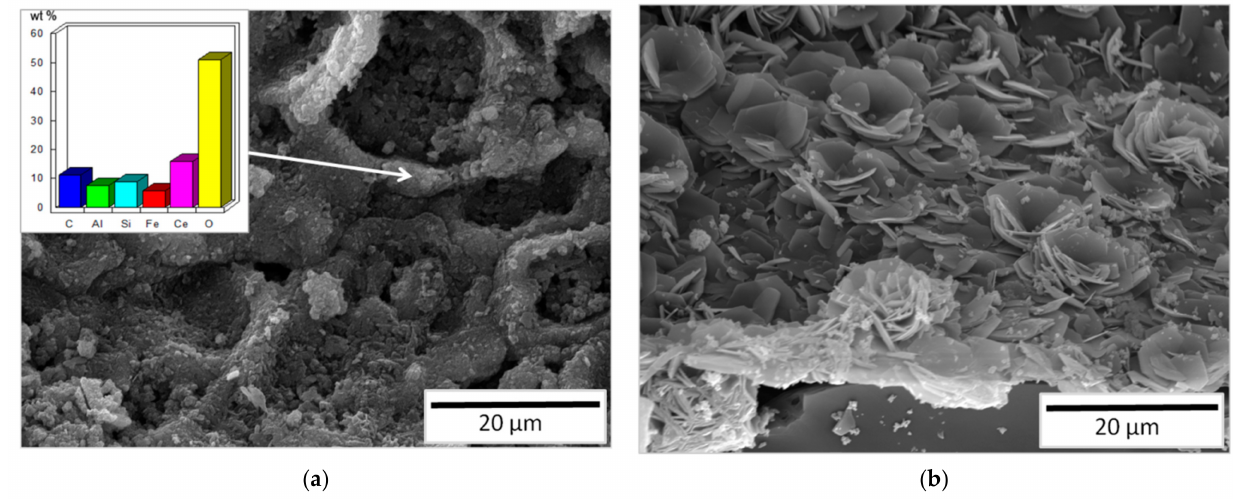
Figure 11. SEM images: Si-Al biomineral film ( a ), vermicular kaolinite over biomineral film ( b ).